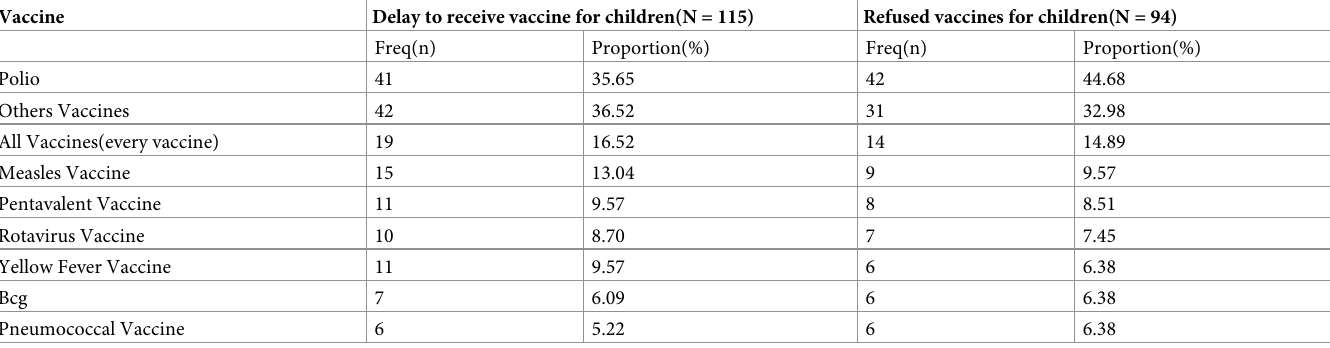
Table 2. Refusal and delayance proportion per EPI vaccine as a proportion of vaccine hesitancy.